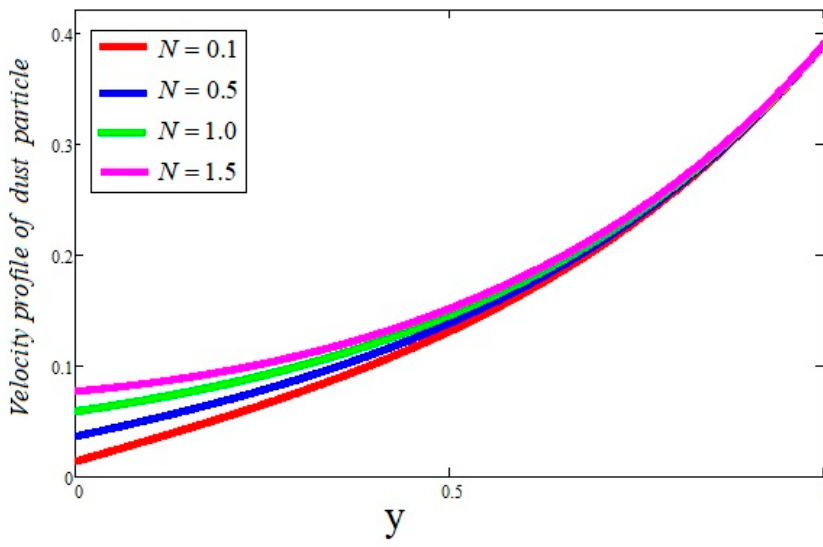
Figure 7. Impact of N on the profile of dust particle velocity.